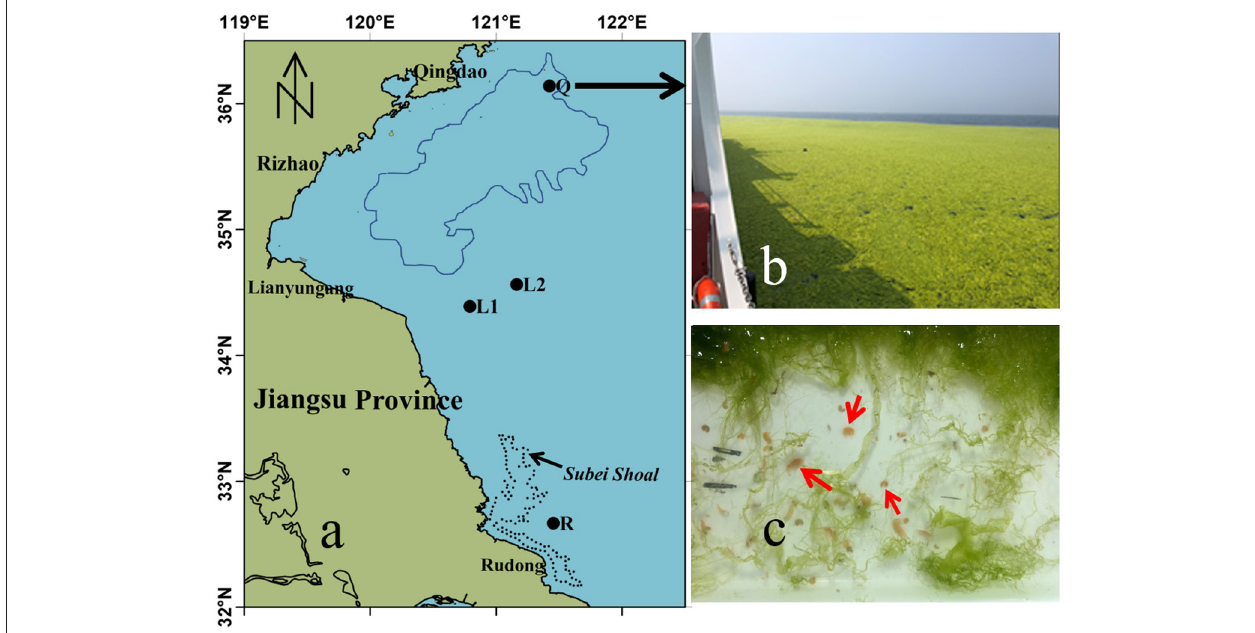
FIGURE 1 | Maps of sampling stations in the southwestern Yellow Sea. (a) locations of sampling stations Q (Qingdao), L1 and L2 (Lianyungang) and R (Rudong, Subei Shoal). The blue line encloses the distribution of floating U. prolifera green tide on June 8, 2020 based on the satellite remote sensing, and the black dotted line is the region of Pyropia aquaculture in Subei Shoal. (b) Field photo of the floating algae at Station Q. (c) Apohyale sp. in the green macroalgae sample.